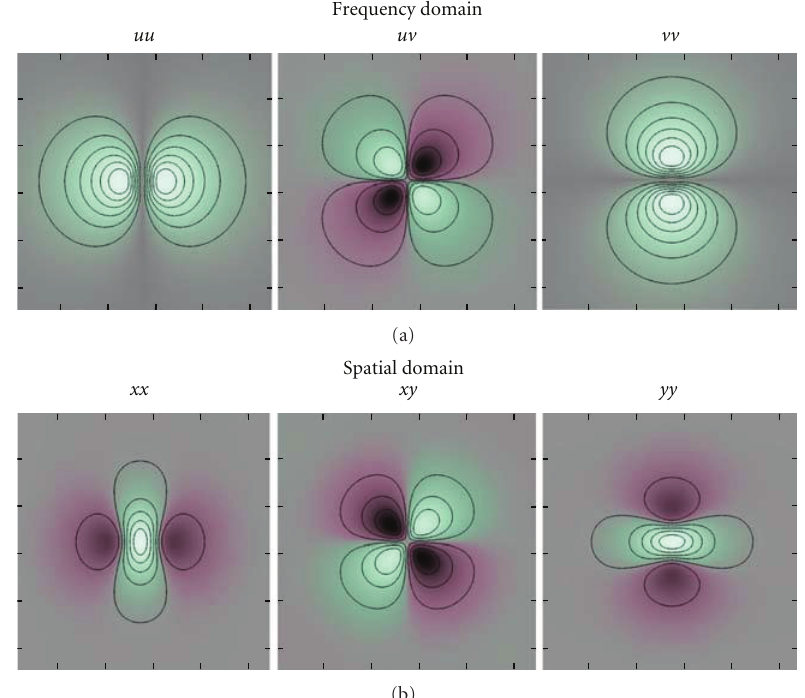
Figure 3: (a) Two-dimensional monomial filters ( uu , uv , v ), of the second order, in the frequency domain. Green indicates positive real values, and red indicates negative real values. The black lines are isocurves. (b) Two-dimensional monomial filters ( xx , xy , yy ), of the second order, in the spatial domain. Green indicates positive real values, and red indicates negative real values. Note that these filters are even and